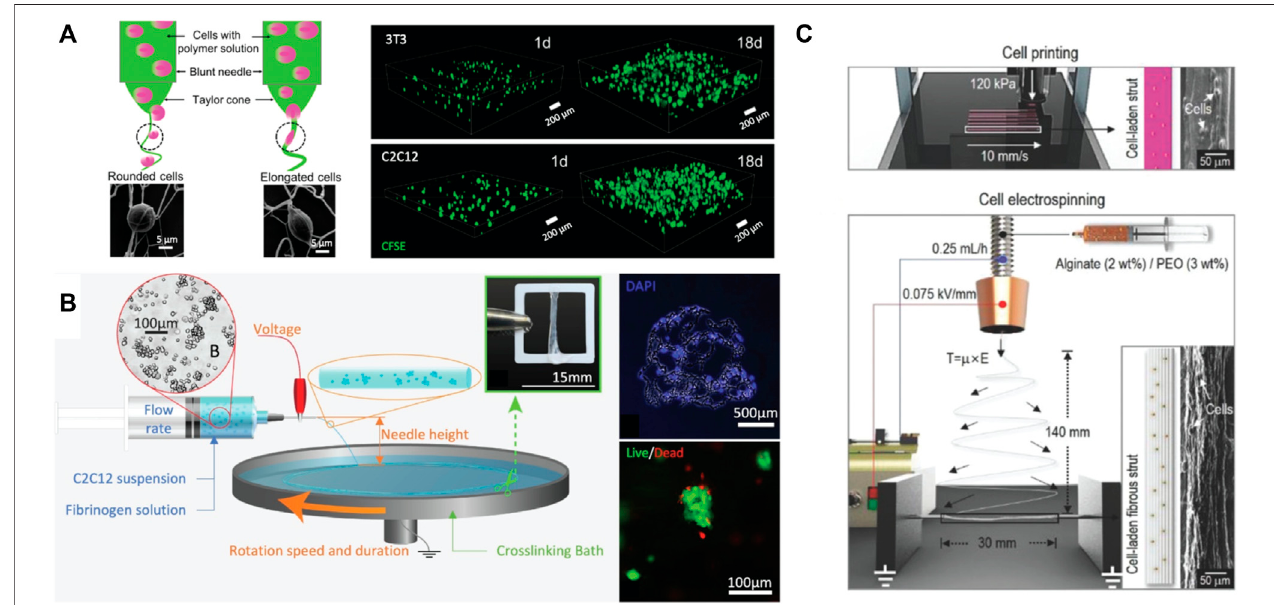
FIGURE 6 | Strategies for cell electrospinning: (A) reactive electrospinning of 3T3 mouse fi broblasts and C2C12 mouse myoblasts in POEGMA hydrogel nano fi bers; (B) cell-laden electrospinning ofC2C12 myoblasts in fi brin scaffolds; (C) combining cell printingand cellelectrospinning toencapsulate C2C12 myoblasts in alginate scaffolds. Reproduced with permission (Xu et al., 2018; Yeo and Kim, 2018; Guo et al., 2019).